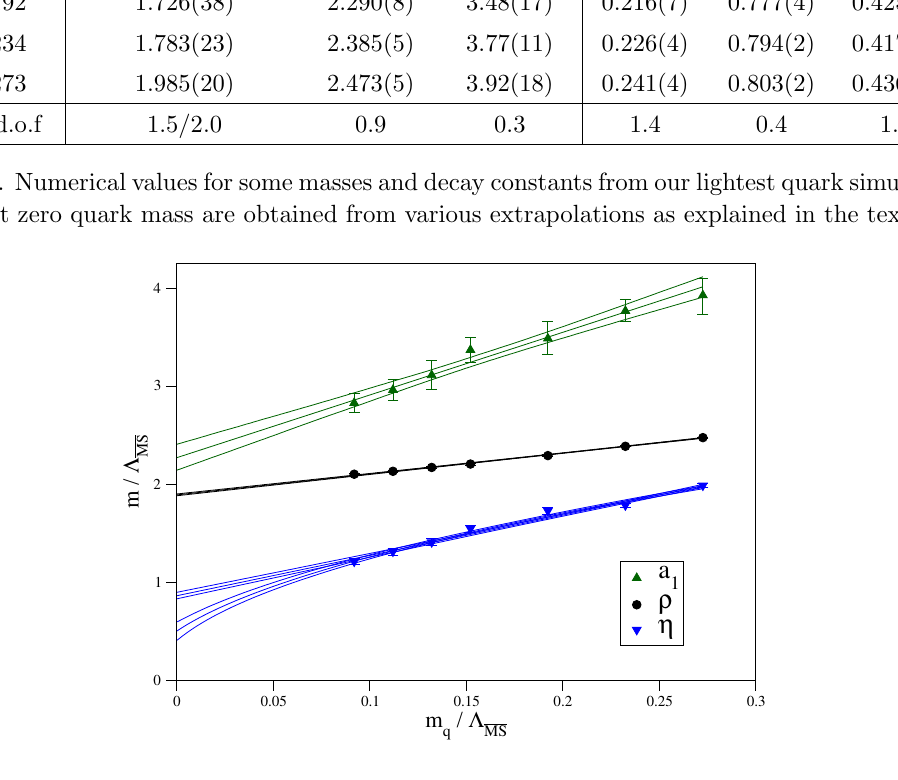
Figure 2 . Masses of the (cid:17) , (cid:26) , and a 1 hadrons for our (cid:12)ve lightest quark masses and the (cid:12)ts used to determine their values in the massless quark